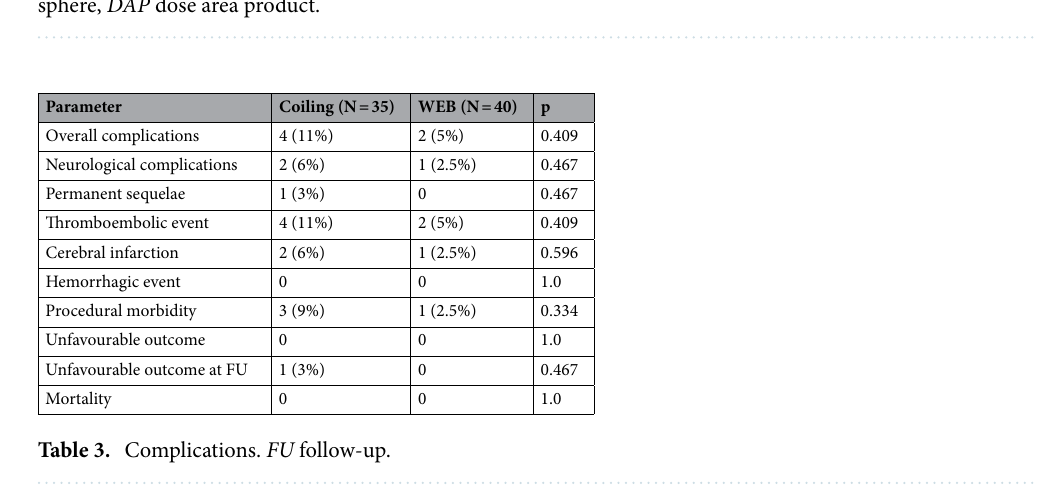
Table 2. Aneurysm treatment and procedural specifics. DL double layer, SL single layer, SLS single layer sphere, DAP dose area product.